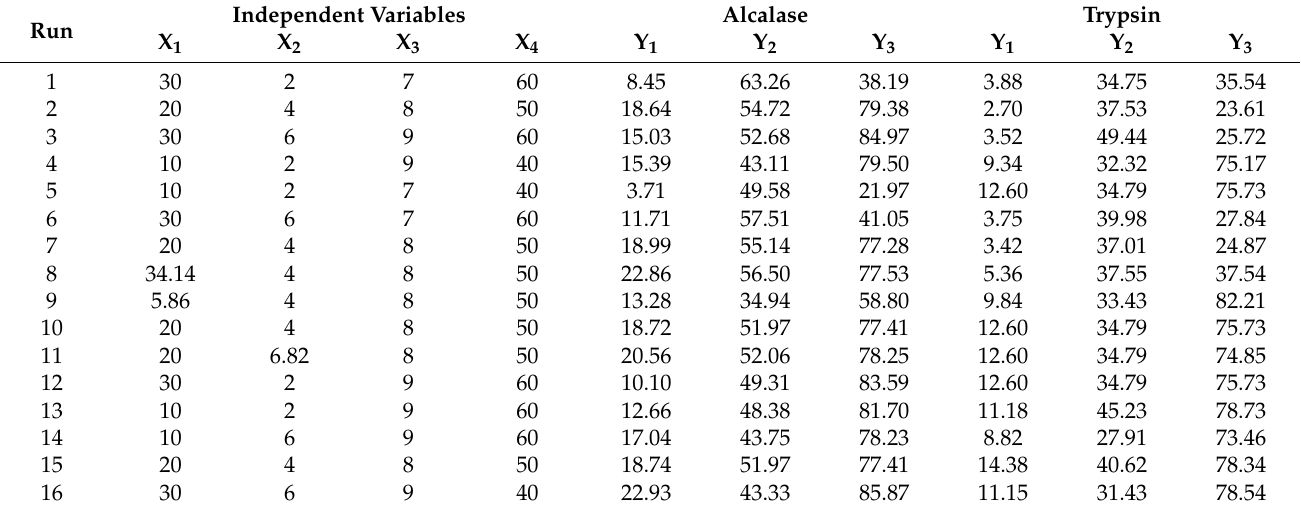
Table 3. Actual levels of independent variables along with the obtained values for the response